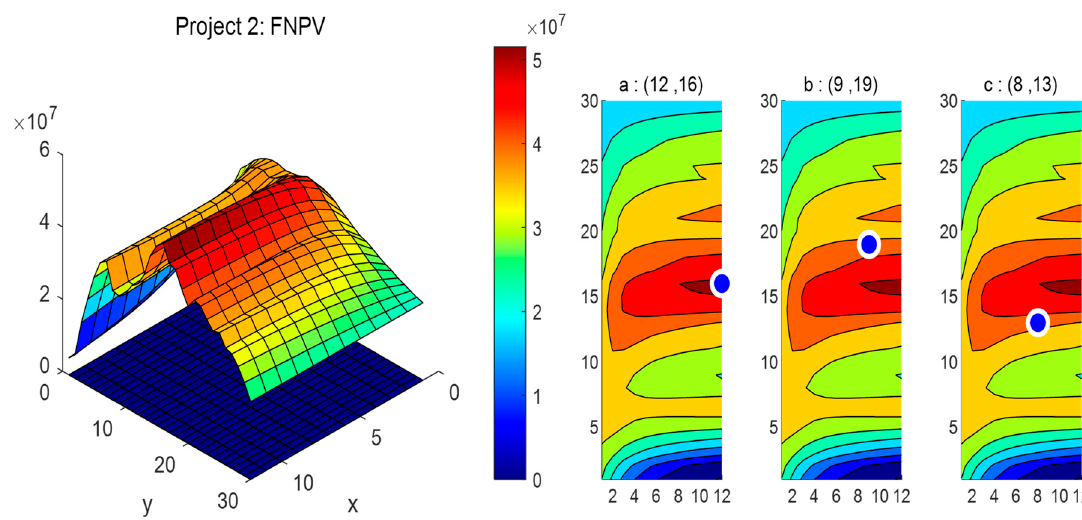
Figure 16. Decision − making for project 2.